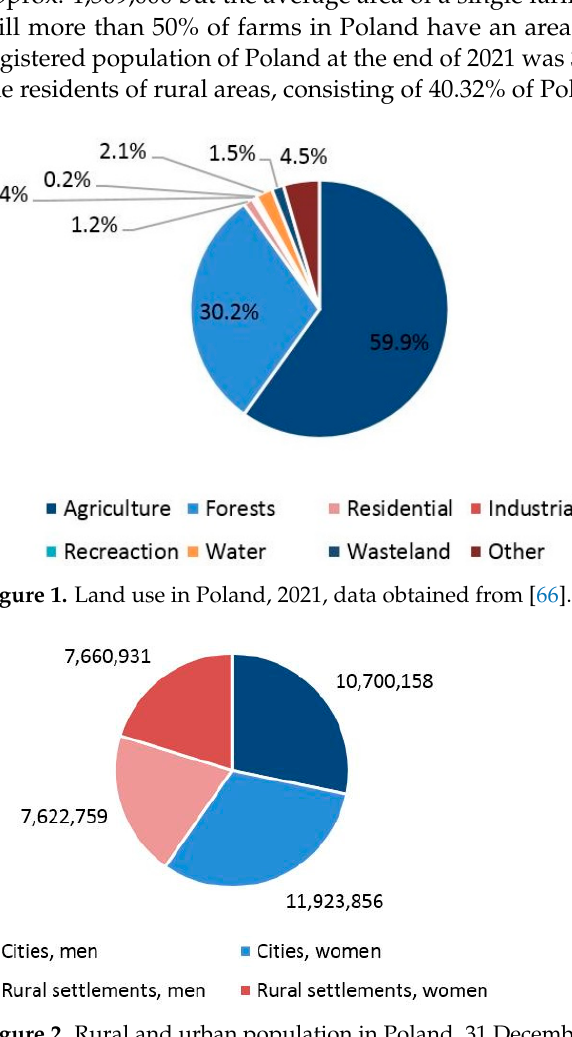
Figure 2. Rural and urban population in Poland, 31 December 2021, data obtained from [66].